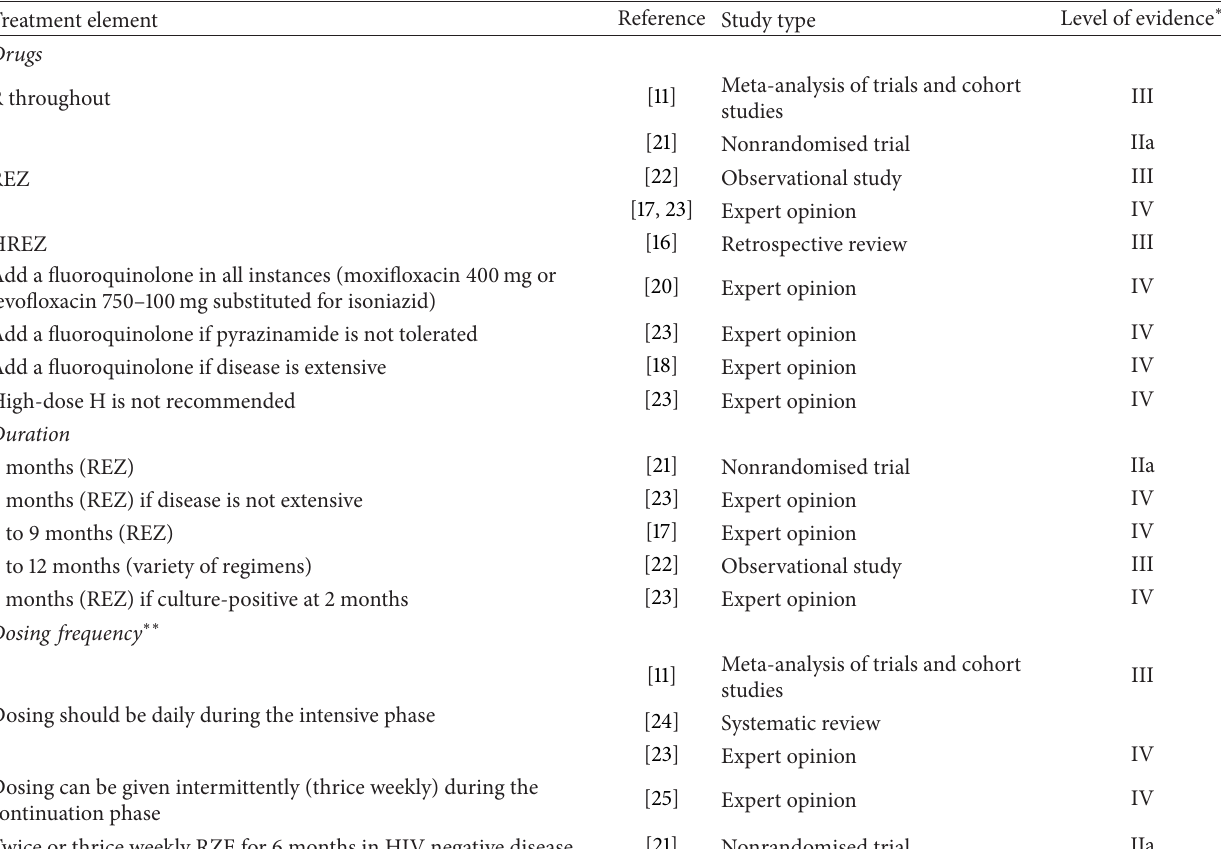
Table 1: Treatment of isoniazid-resistant pulmonary tuberculosis: recommendations from selected references and level of evidence. Treatment